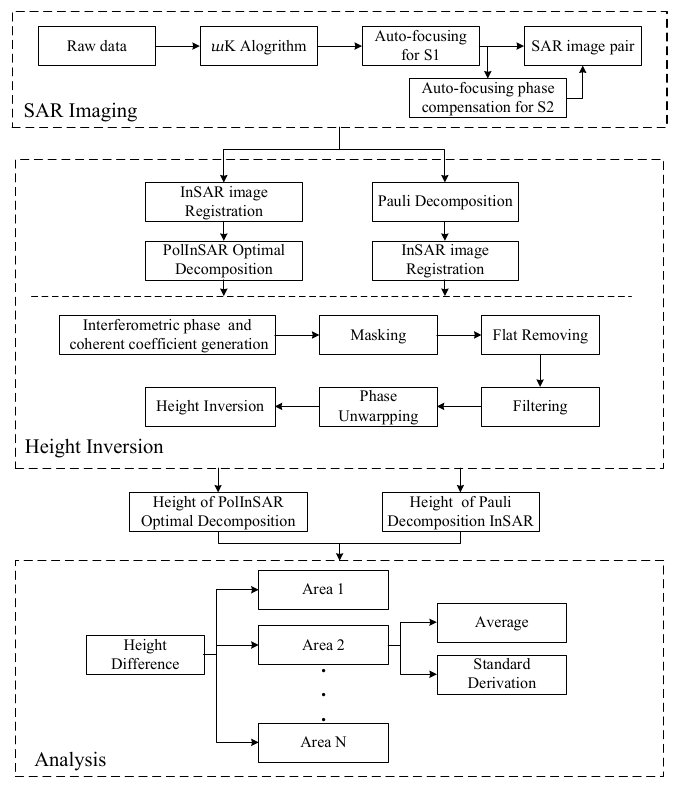
Figure 3. Flow chart of retrieving height.